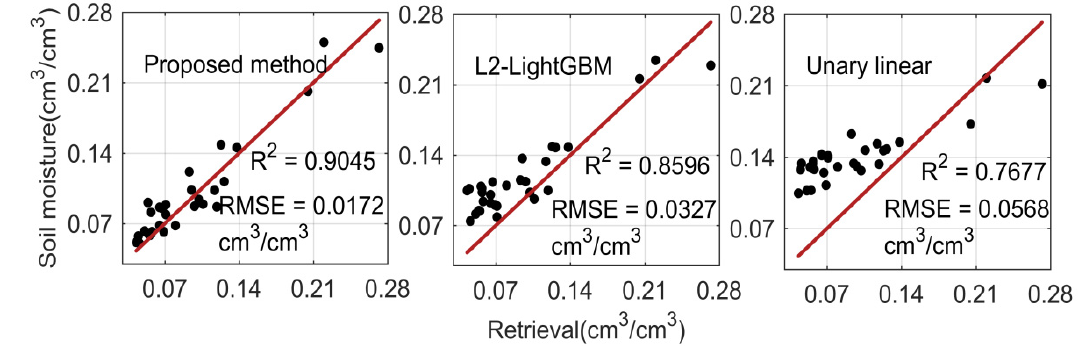
Figure 13. Correlation between three methods and soil moisture in station P041.